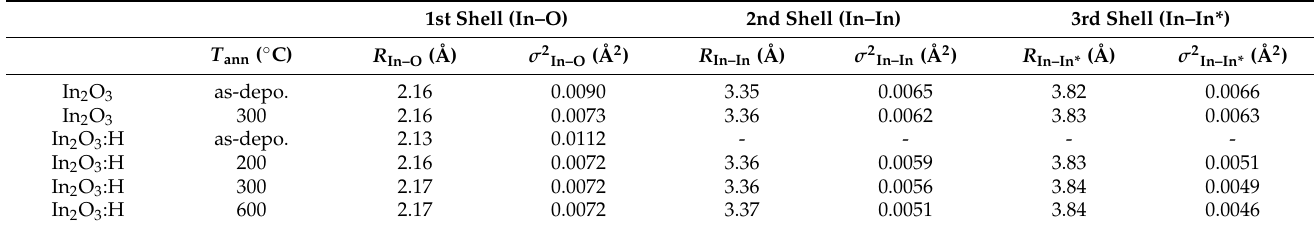
Table 1. EXAFS fitting results for first, second, and third shells in the In 2 O 3 and In 2 O 3 :H films.